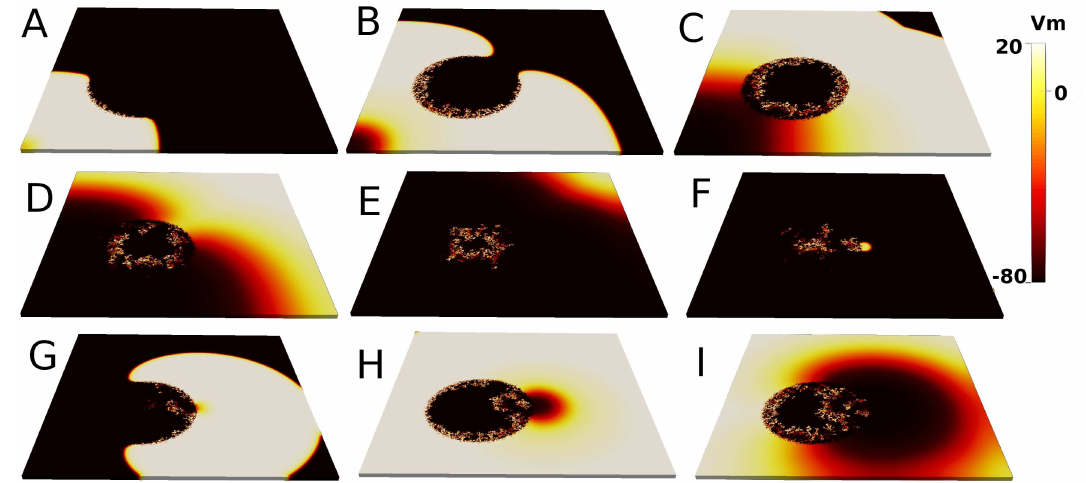
Fig 4. Reentry in a 3D slab of cardiac tissue. Numerical simulationshowingthe reentry from the fibrotic regioninto the wholeslab of tissue. Nine snapshots of the tissue slab every t = 66 ms , therefore for times t = 66 ms , t = 132 ms , t = 198 ms , t = 264 ms t = 330 ms , t = 396 ms , t = 462 ms , t = 528 ms , and t = 594 ms . Parameter values: ϕ = 0.72, t o is 7 × 7 × 0.1 cm 3 ( N = 10 layers), radius of the fibrotic region R o = 1.4 cm , and total time of simulation t = 1500 ms